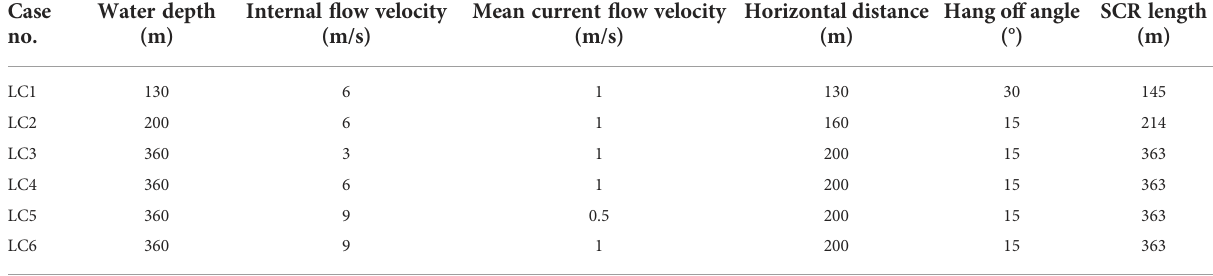
TABLE 5 Load case